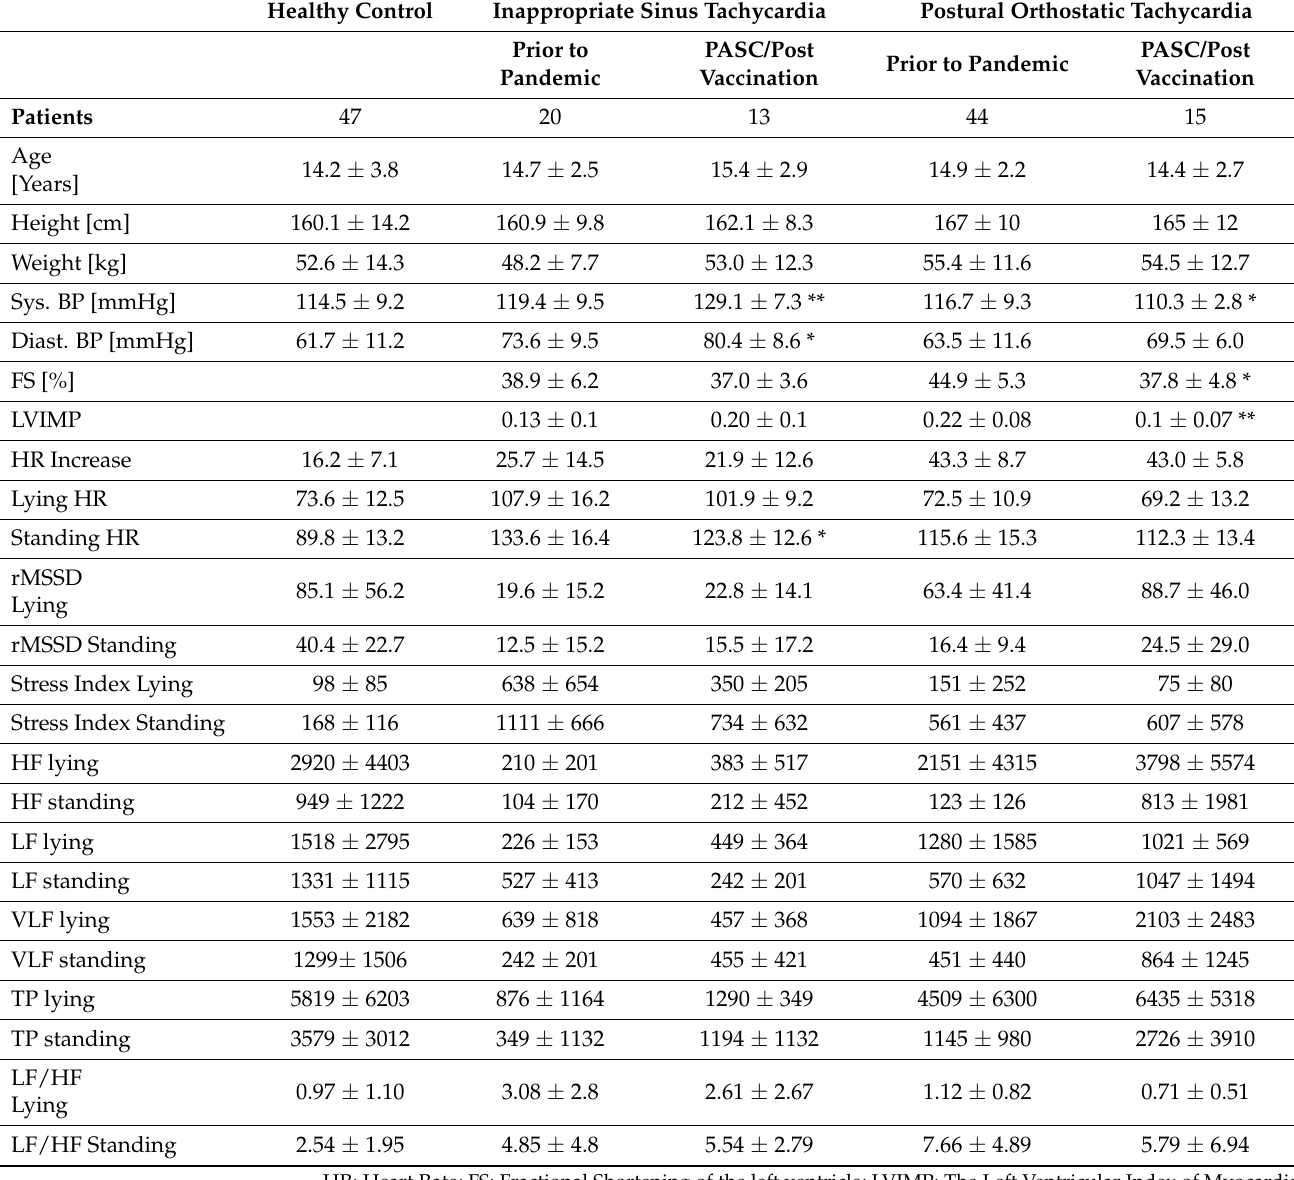
Table 1. Measurements during active standing test in children with dysautonomia.